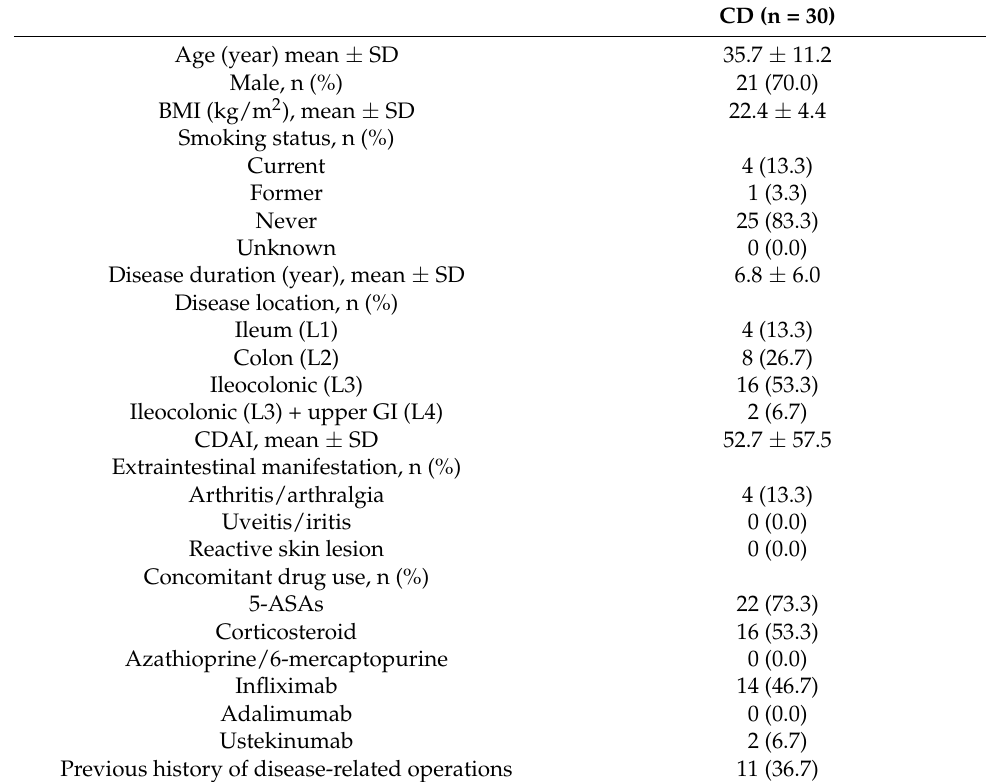
Table 1. Baseline demographic and clinical characteristics of